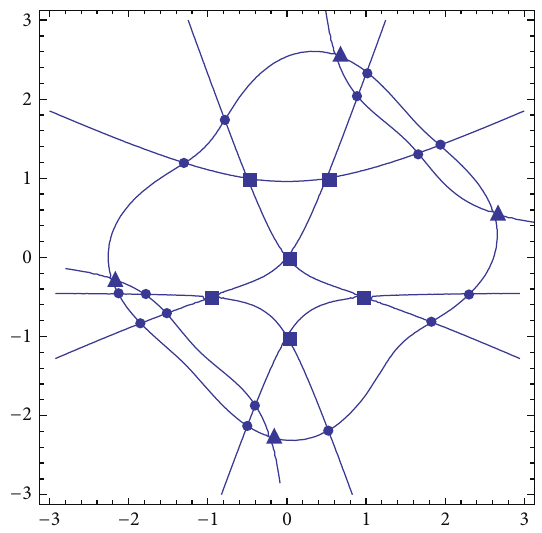
Figure 4: Real part of 𝑓 1 (𝑥,𝑦) = 0 in Example 2.